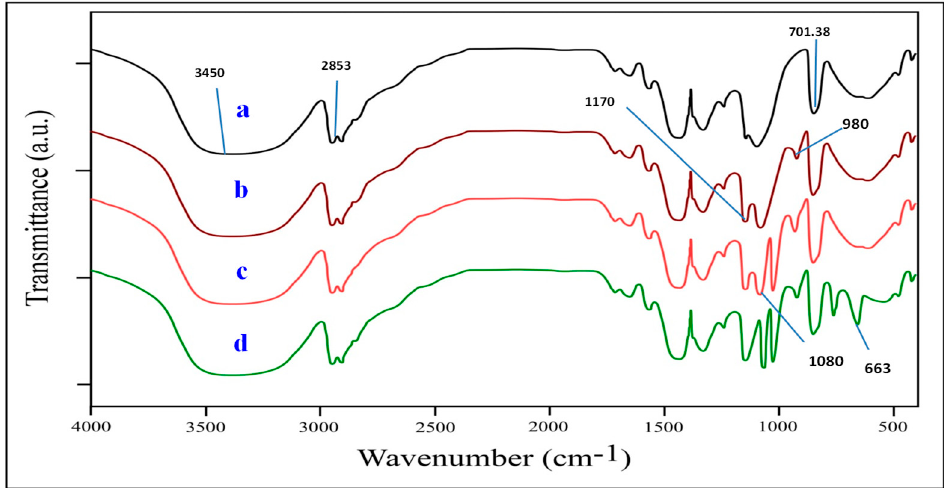
Figure 1. FTIR spectra of ( a ) unmodified PVA; ( b ) PPVA; ( c ) PPVP and ( d ) PPVP-Zr after chelation.